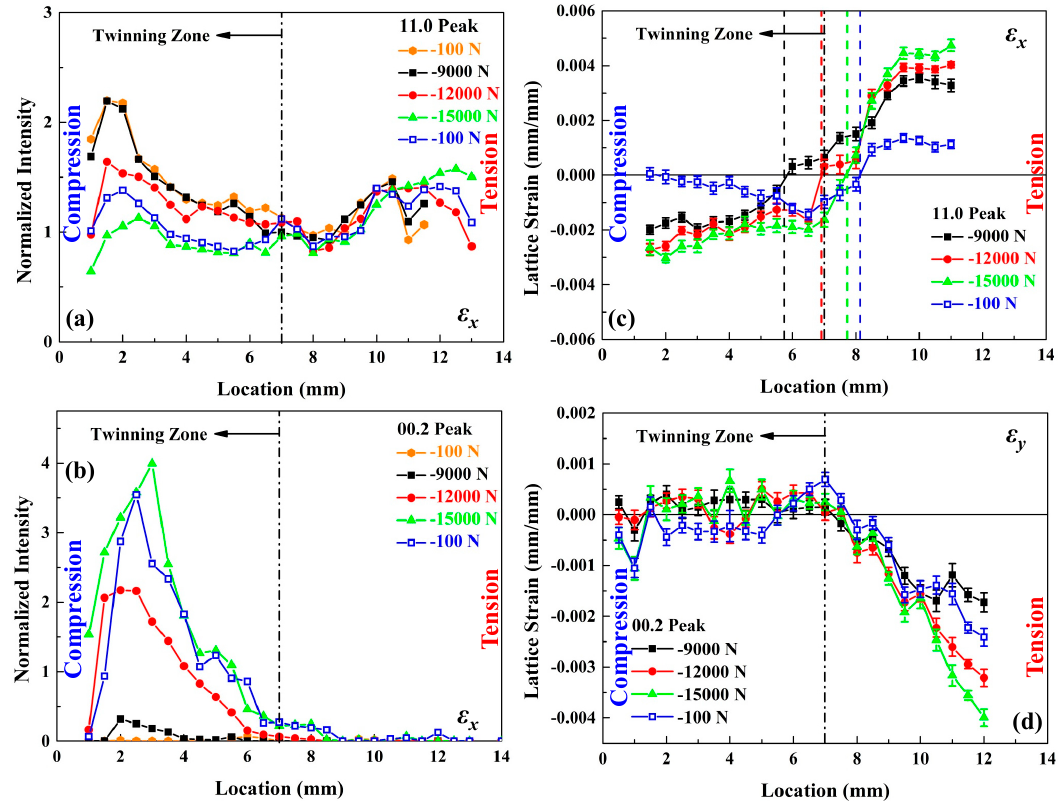
Figure 3. ( a , b ) The diffraction peak intensity variations of (11.0) and (00.2) grain in the ε x direction during in situ loading-unloading, respectively; ( c , d ) The lattice strain evolution of (11.0) and (00.2) grains in the ε x and ε y directions, respectively.